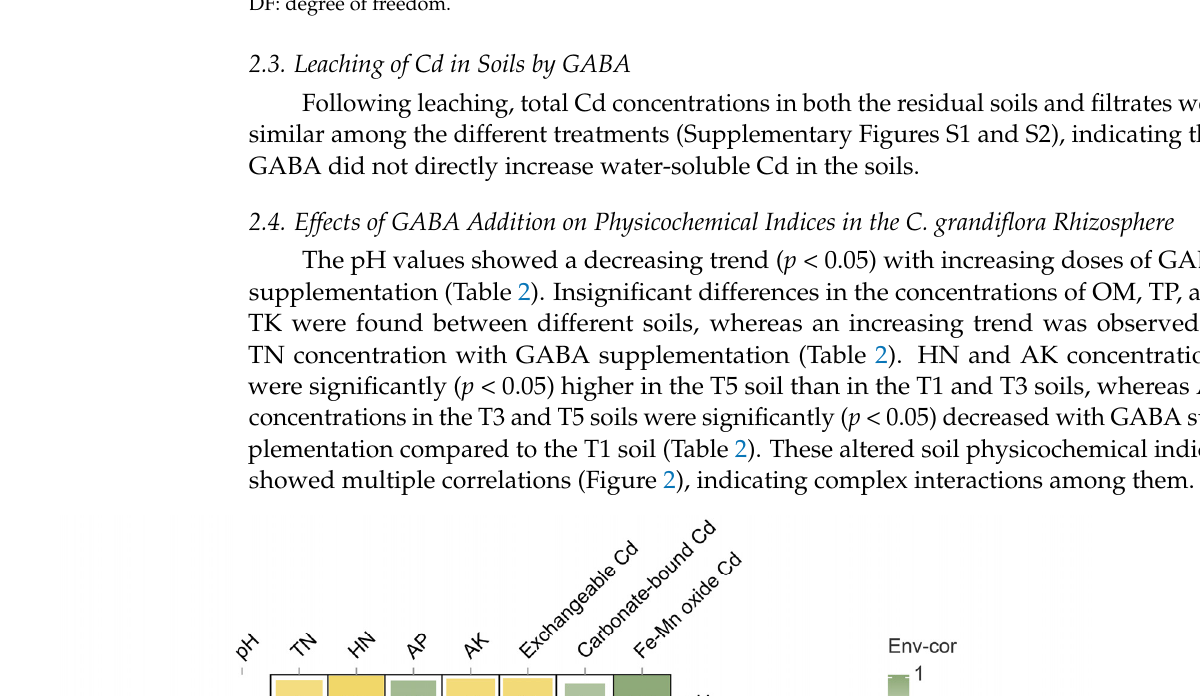
Data represent the means ± standard deviations (n = 3); data in the same row labelled with different letters (a, b, and c) indicate significant differences ( p < 0.05, Duncan’s test, one-way ANOVA) among different treatments. DF: degree of freedom.